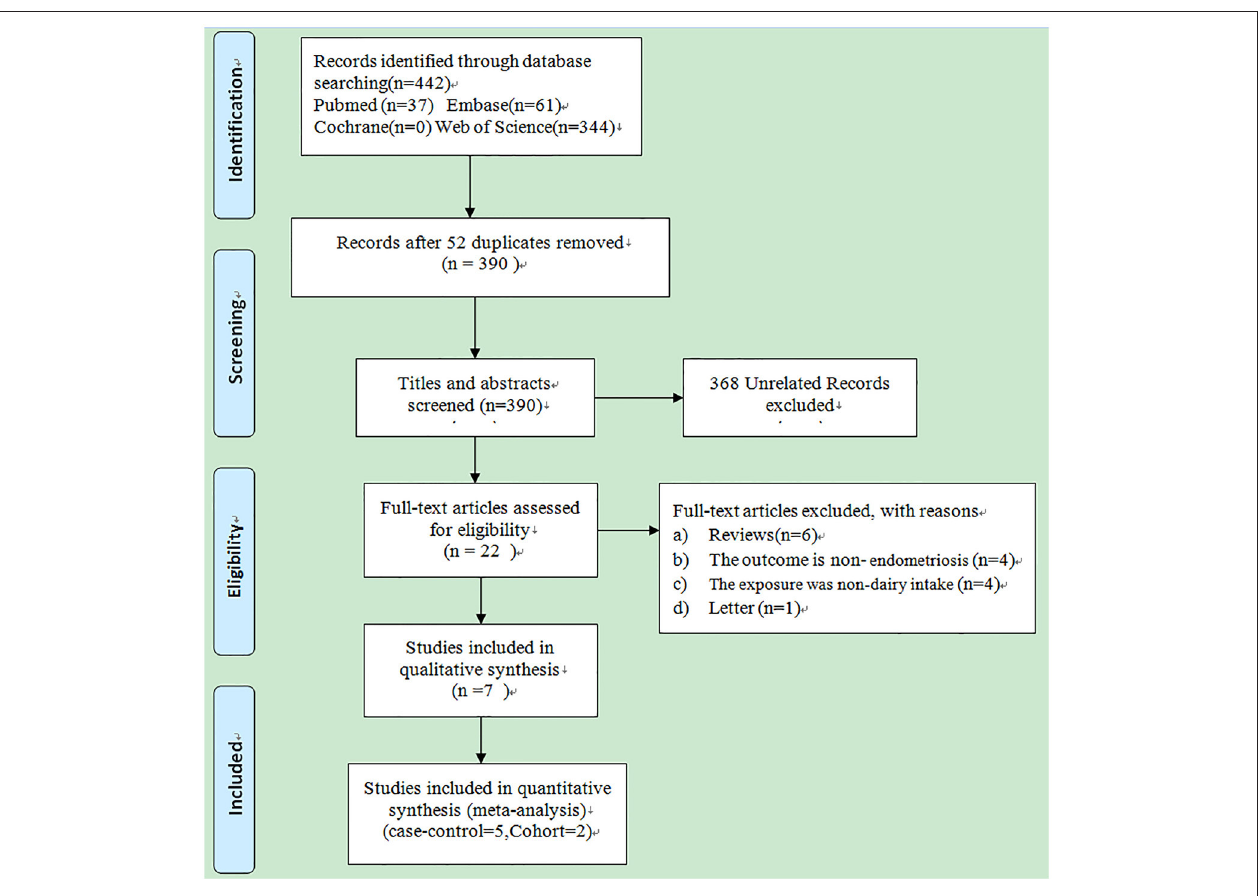
FIGURE 1 | Flow chart of the study retrieval